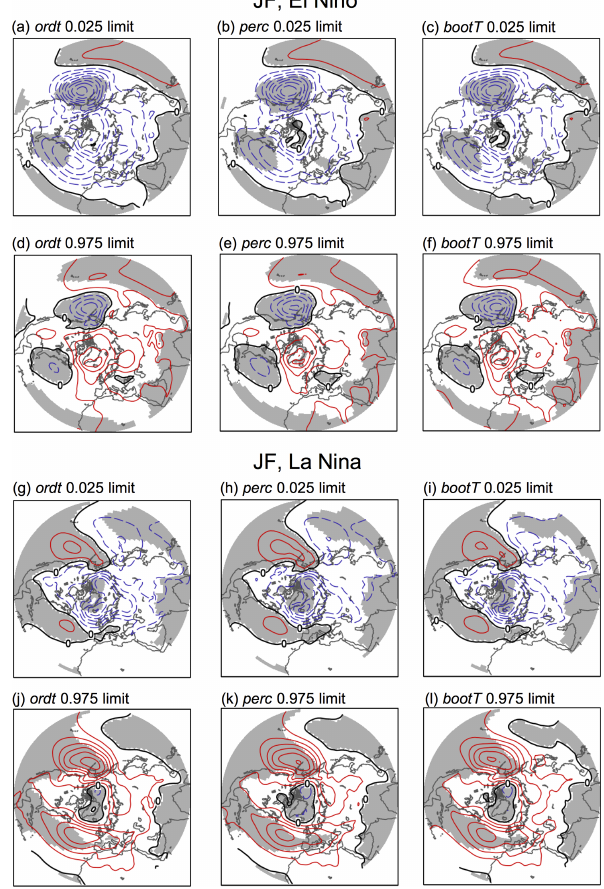
Figure A7. Lower and upper limits of confidence intervals (at 95% level) for JF El Niño and La Niña SLP composites corresponding to Fig. 5c and d. The ordt , perc , and bootT intervals are described in Sect. 3.3. The contour interval is 1hPa, with red (blue) contours in- dicating positive (negative) anomalies. Gray shading indicates loca- tions where the SLP anomalies have the same sign within the entire